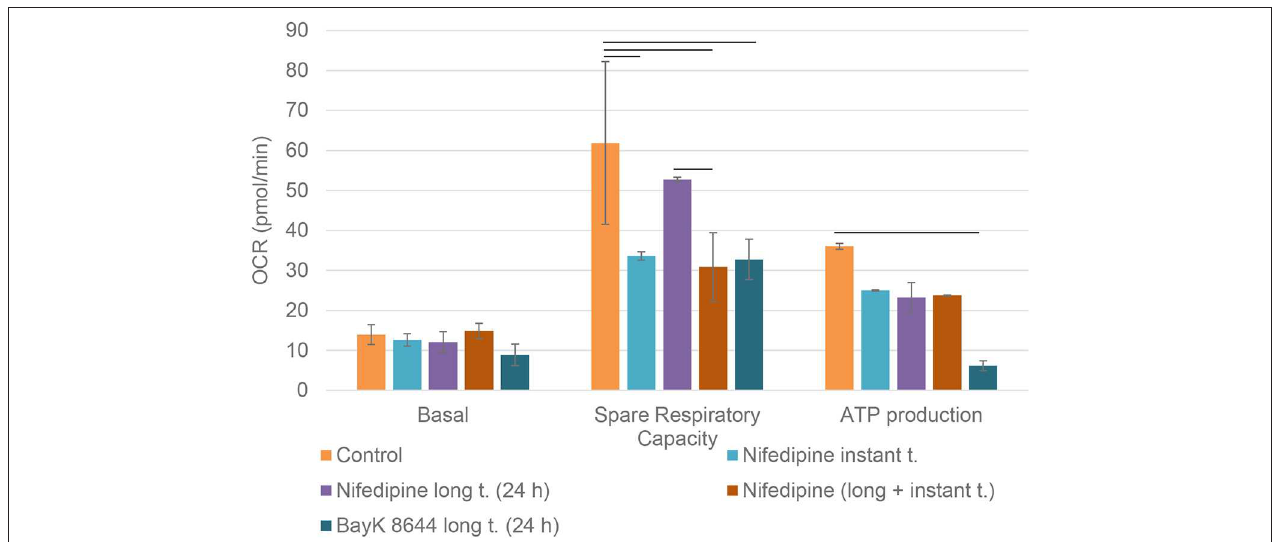
FIGURE 3 | Mitochondrial respiration capacity in chondrocytes. The cells were treated with nifedipine (10 µ M) and BayK8644 (10 µ M) for 24h (long t.), and additionally treated with nifedipine (10 µ M) during the measurement (instant t.). Basal, spare respiratory capacity and ATP production are presented. OCR, oxygen consumption rate. Horizontal bars represent p <